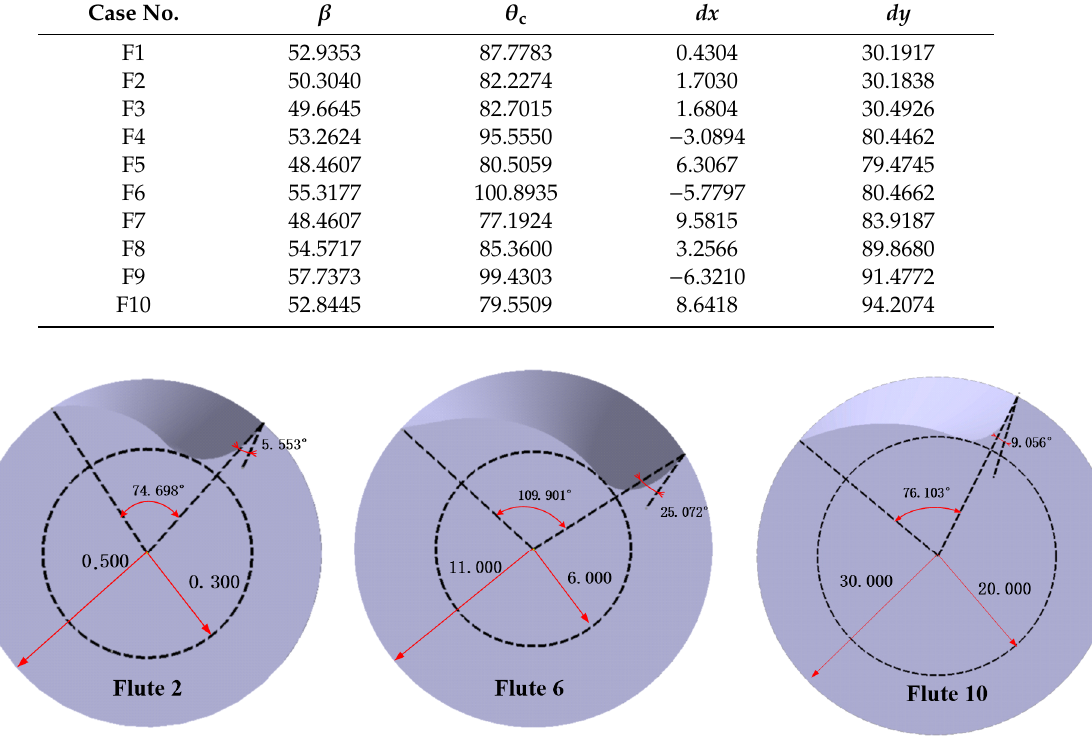
Figure 8. Simulated cutting tool flutes by CATIA.